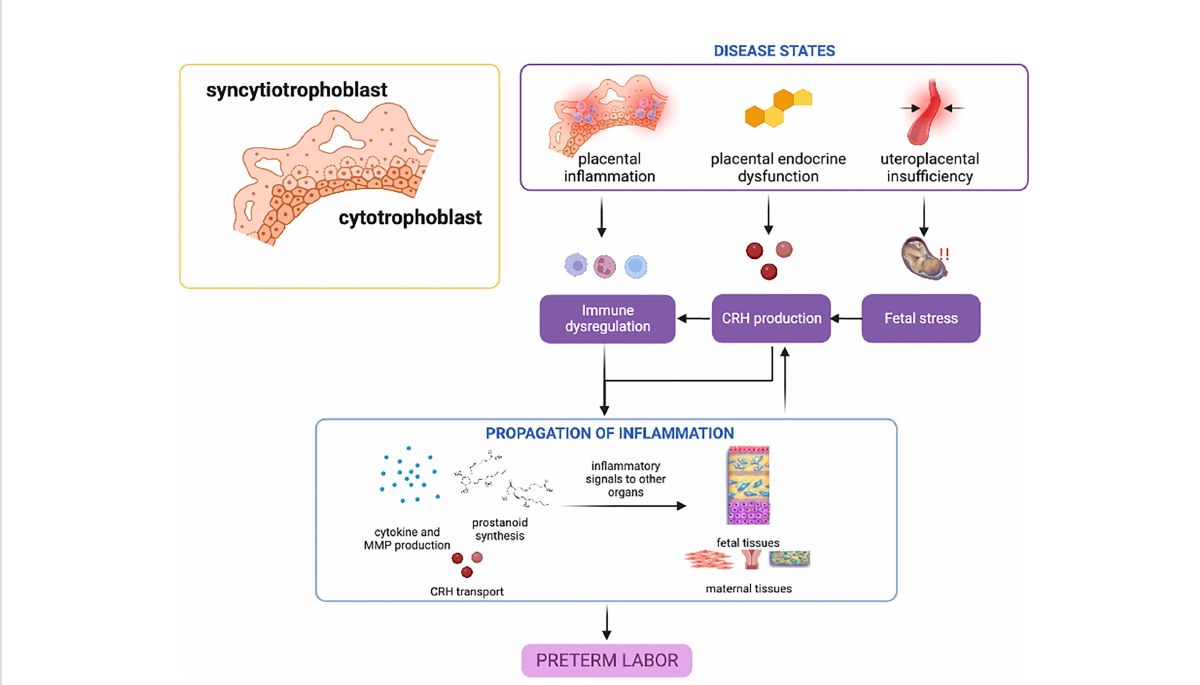
FIGURE 1 Disease states in the placenta contributing to preterm birth. Placental in fl ammation, endocrine dysfunction, and uteroplacental insuf fi ciency can lead to in fl ammatory activation and propagation of in fl ammatory mediators towards other gestational tissues. CRH may play the predominant role in these placental disease states, with in fl ammation providing a feed-forward mechanism. This fi gure was created with